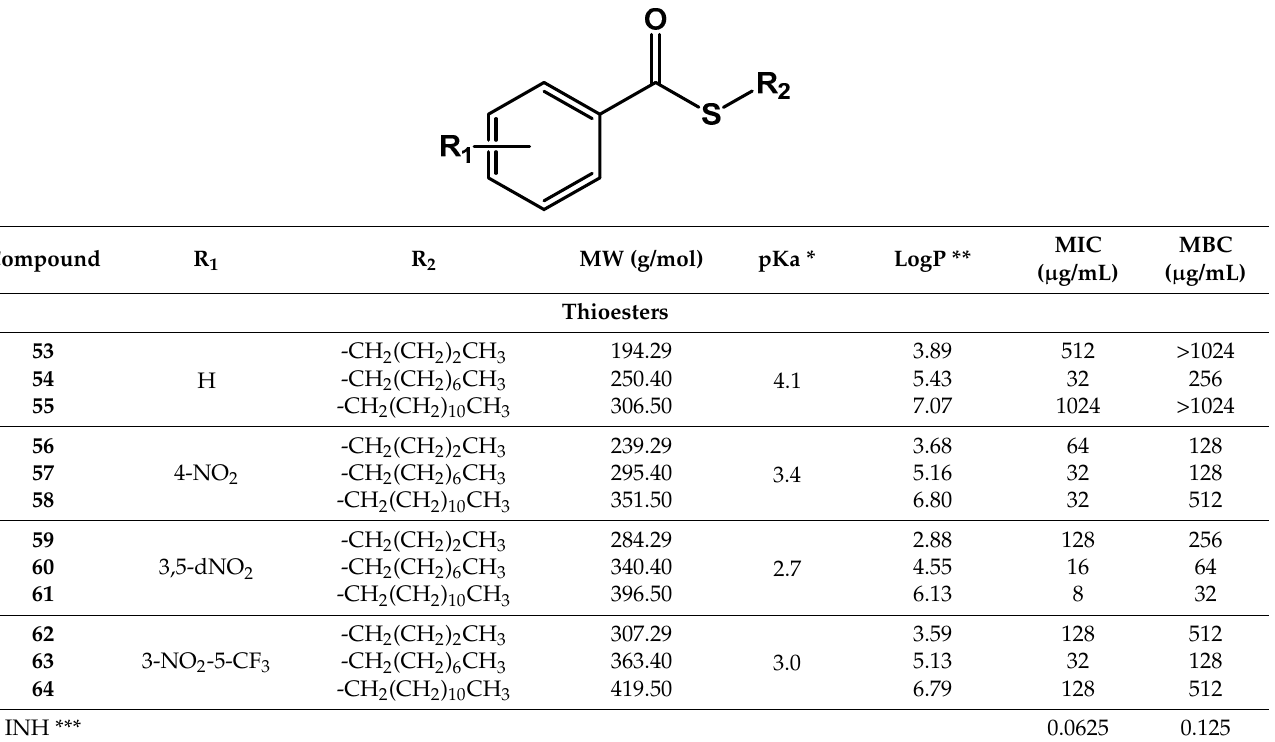
Table 2. Structure, physical properties, and antitubercular activity of benzoate thioesters against Mtb H37Rv.